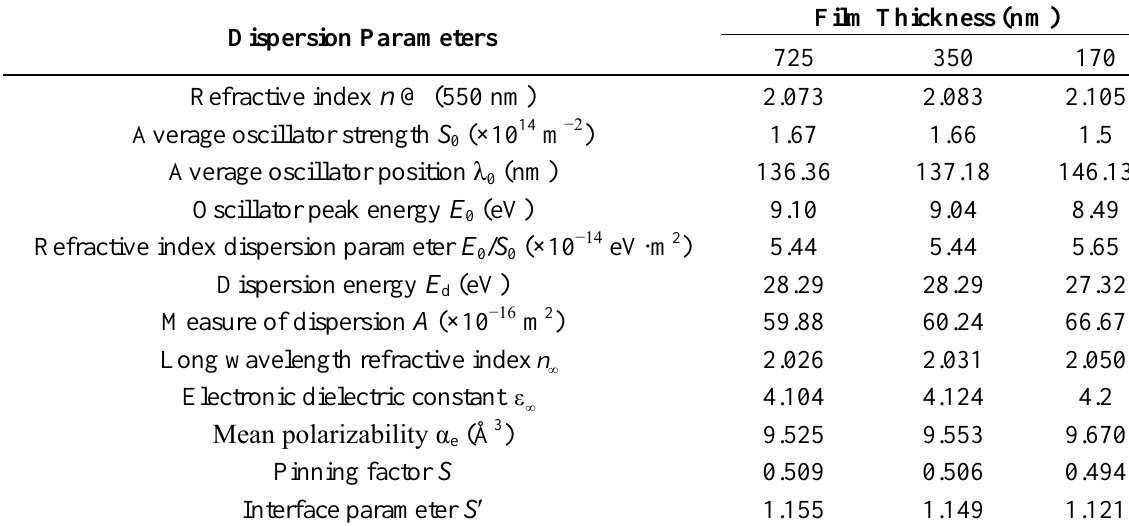
Table 2. Dispersion parameters of the index of refraction of amorphous LaGdO